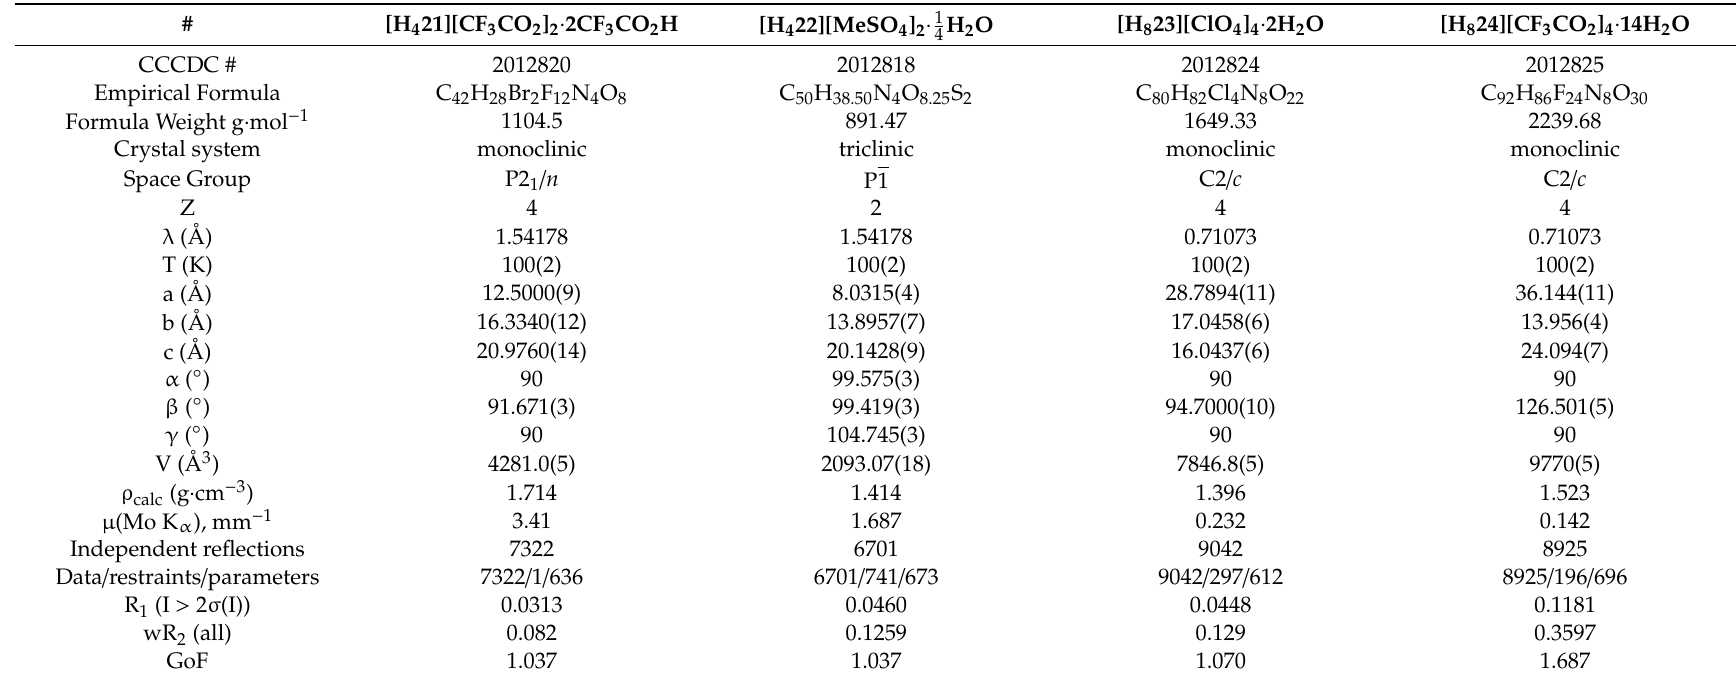
Table 3. Crystallographic tables for compounds